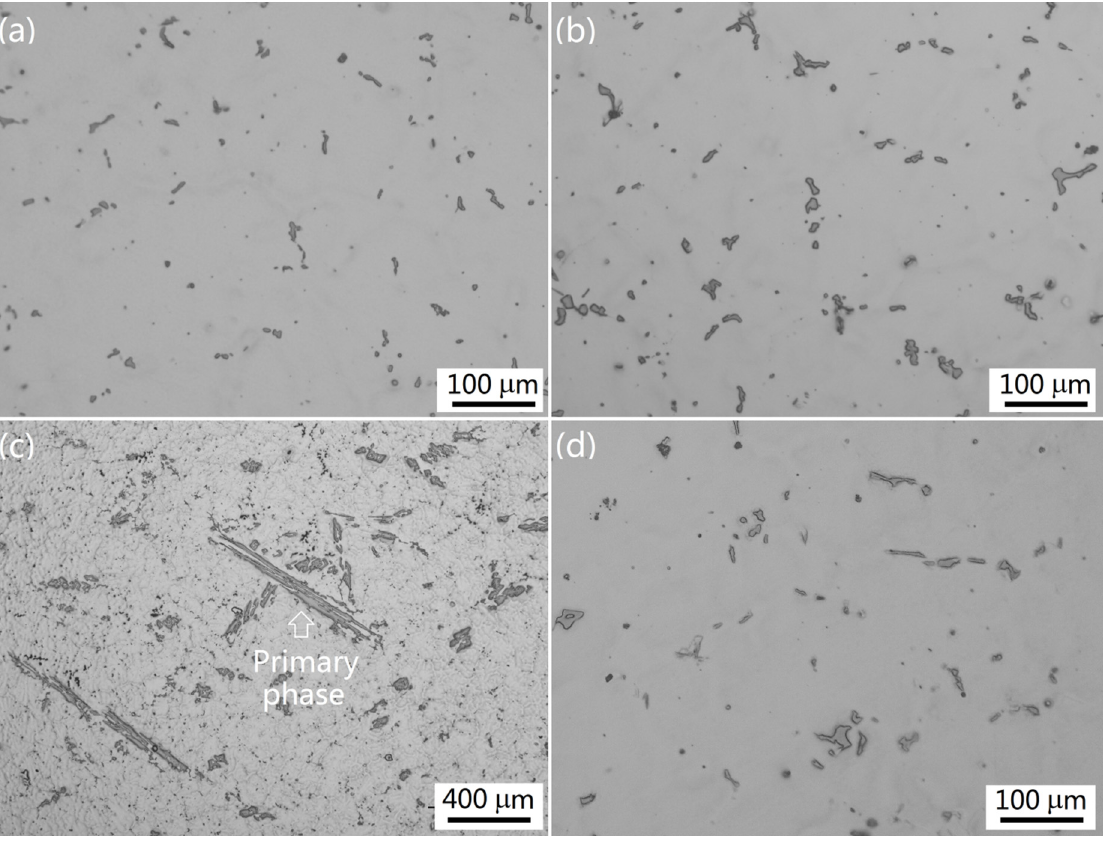
Figure 3. The as ‐ cast microstructures of the Group I alloys solidified under near ‐ rapid cooling: Figure 3. The as-cast microstructures of the Group I alloys solidified under near-rapid cooling: ( a ) Alloy I ‐ 1; ( b ) Alloy I ‐ 4; ( c , d ) Alloy I ‐ 5. ( a ) Alloy I-1; ( b ) Alloy I-4; ( c , d ) Alloy